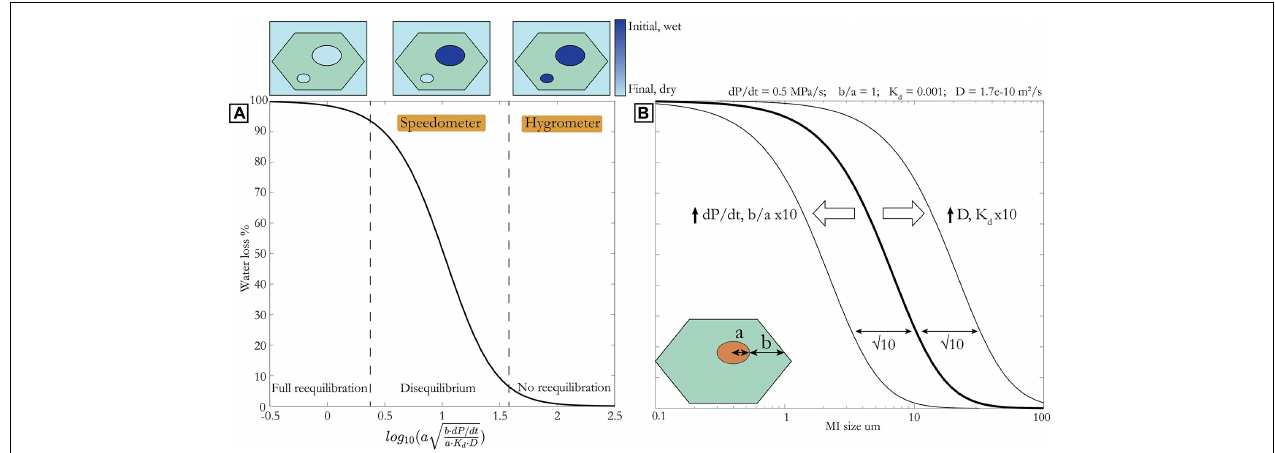
FIGURE 5 | (A) % Water loss against x (see Eq. 2) for boundary condition of open system degassing modeled using SolEx (Witham et al., 2012) for initial volatile concentrations of 1,000 ppm CO 2 , 4.75 wt% H 2 O. Initial pressure is 400 MPa. Upper left portion indicates ∼ complete water loss (MIs are in equilibrium with groundmass). Central portion indicates water loss dependent on MI size and distance to olivine rim (MIs are in disequilibrium) – this regime is best suited for speedometry. Lower right portion indicates minimal water loss (MIs are still in equilibrium with initial wet magma) – this regime is best suited for hygrometry. Panel (B) same as panel (A) but with × axis as MI radius and all other parameters fixed as indicated above. Arrows and thin curves show effect of changing these parameters. Inset schematic of olivine and melt inclusion illustrates parameters a and b.